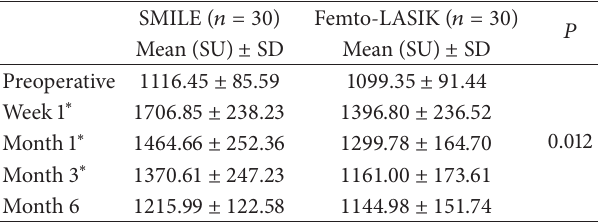
Table 7: Number of reflective